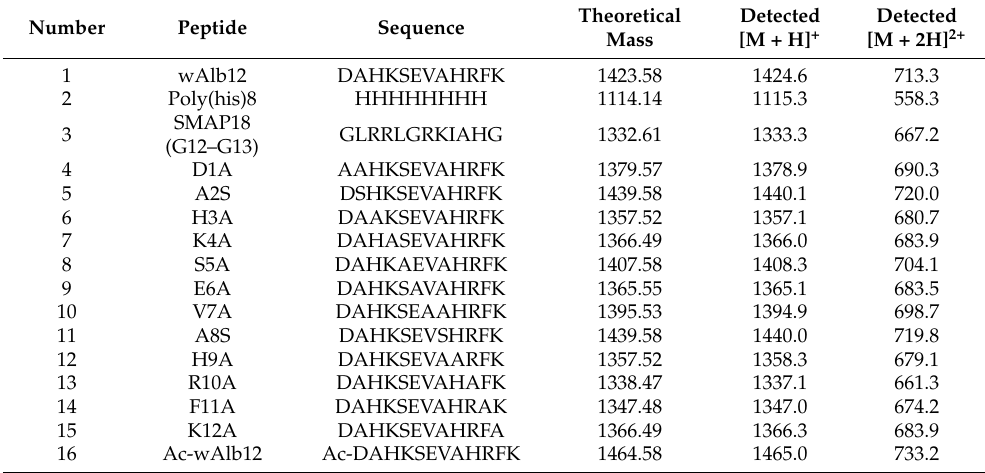
Table 1. Sequences, molecular weights, and detected MS values of the synthesized peptides.